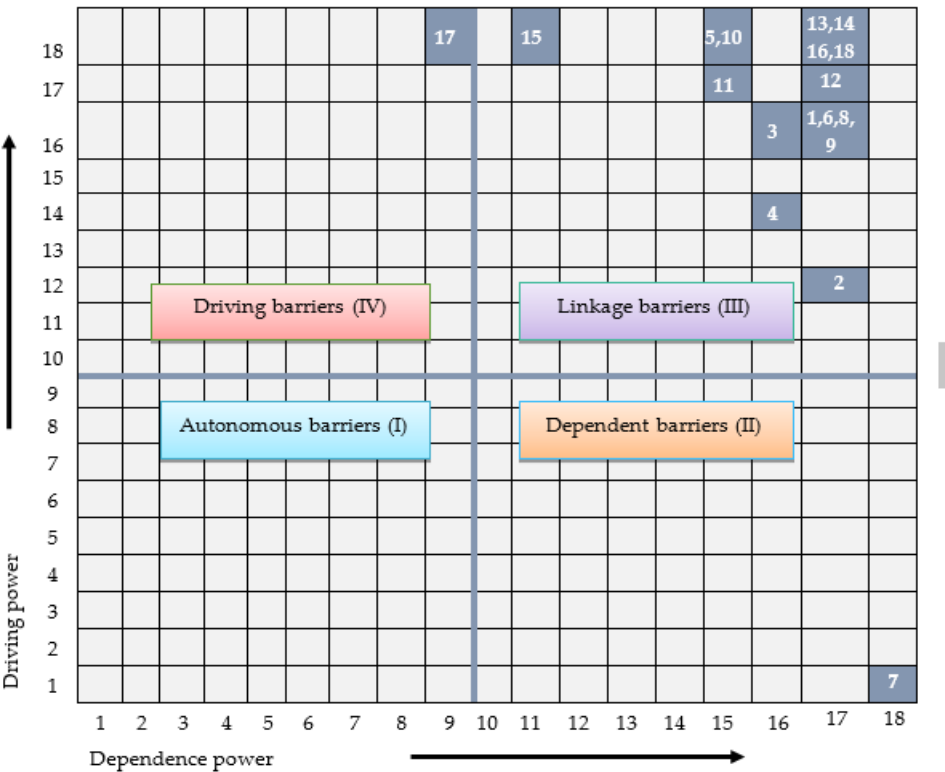
Figure 4. MICMAC analysis of the barriers for the green innovation adoption.